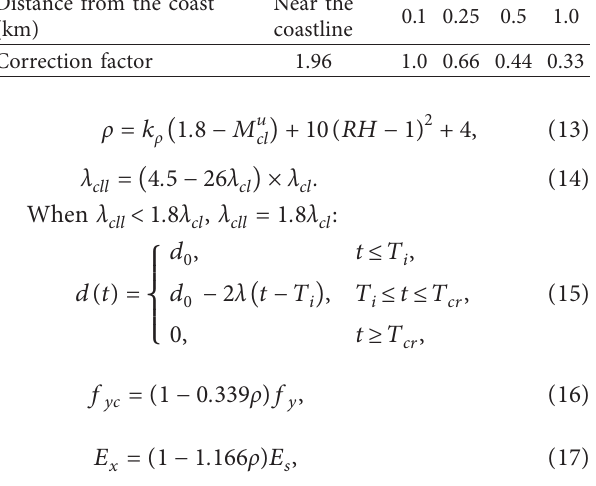
Table 6: Correction coefficient k of chloride ion